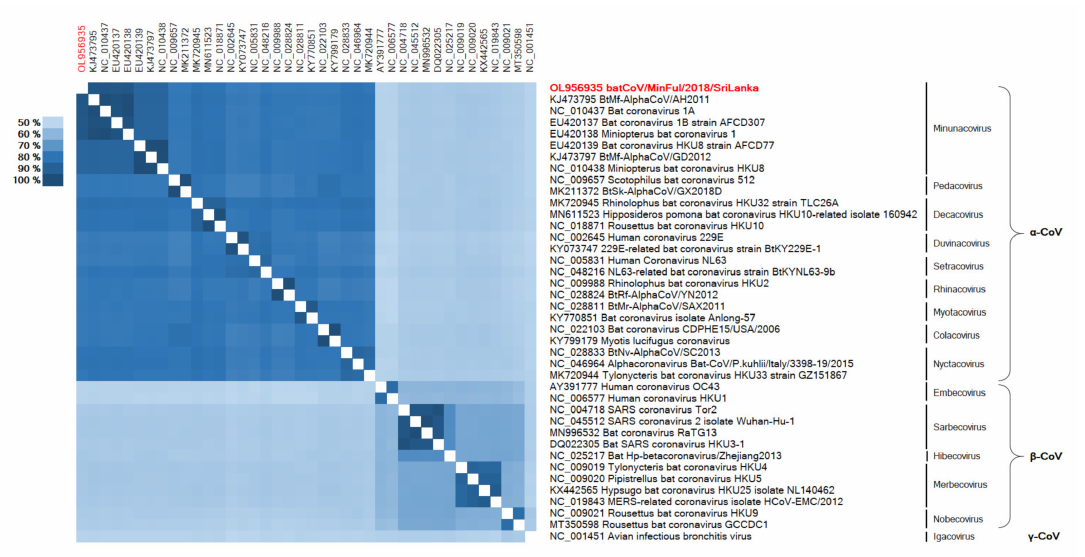
Figure 5. Heatmap based on an ORF1b aa alignment of the novel batCoV/MinFul/2018/SriLanka (red) and 39 selected CoV